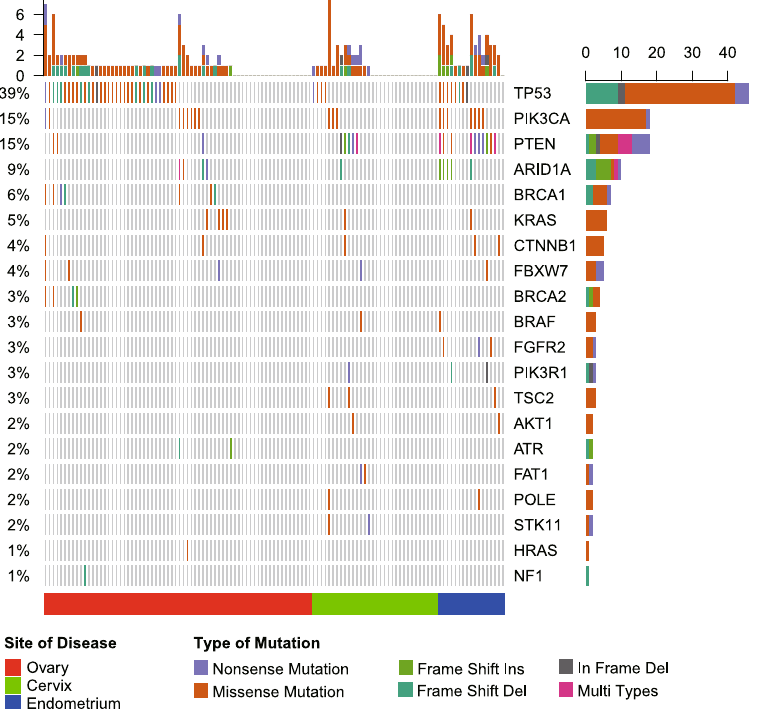
Figure 1. Heat map showing somatic mutation profiles of gynecologic